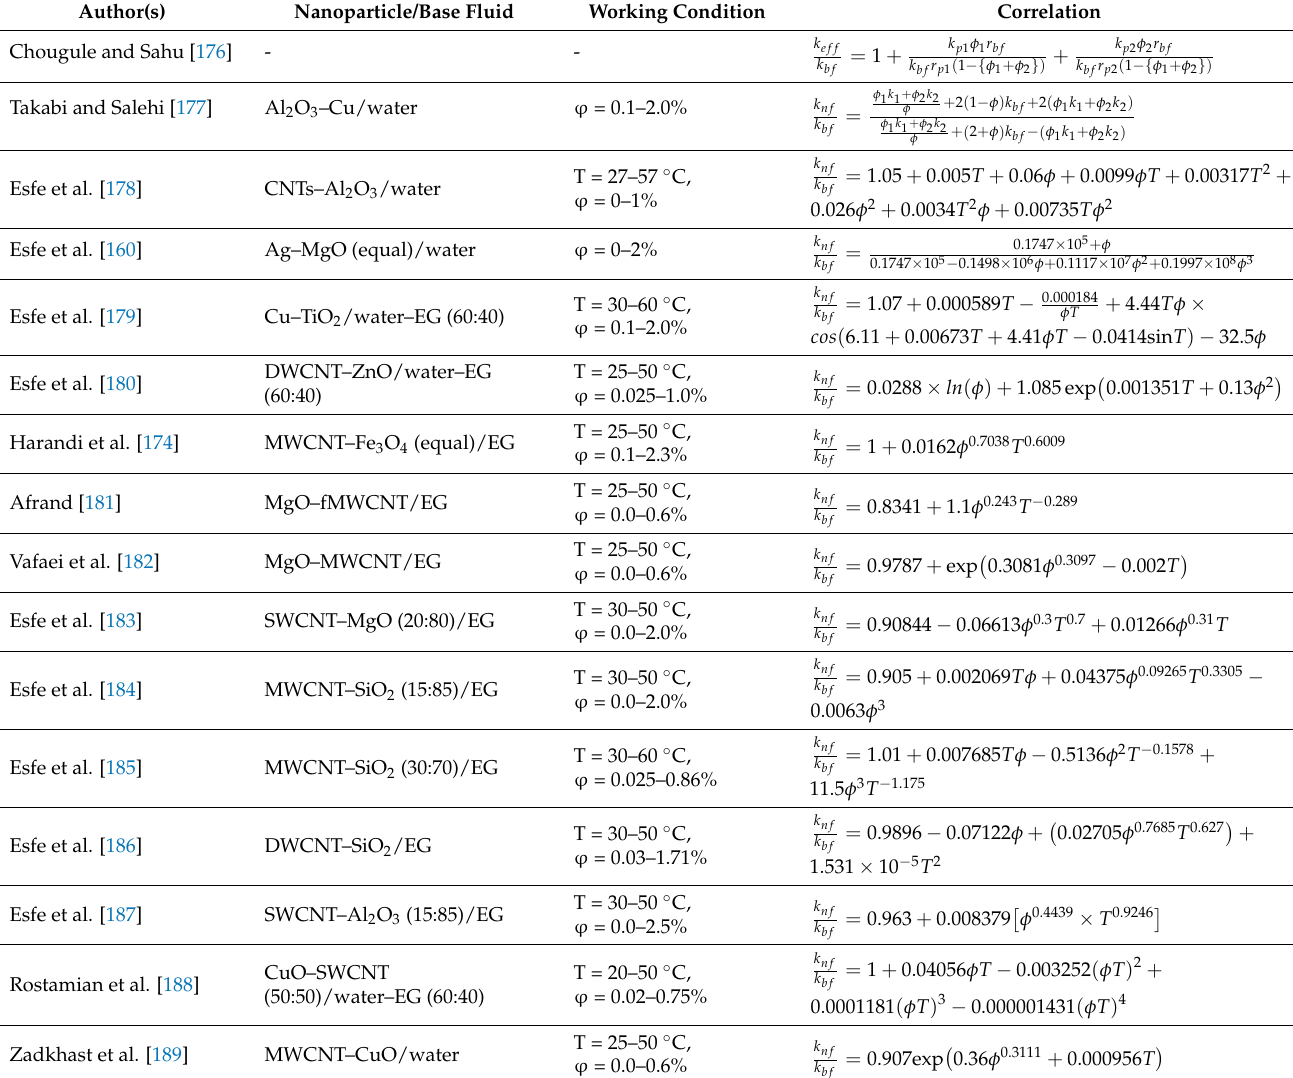
Table 4. Summary of correlation for the thermal conductivity of hybrid